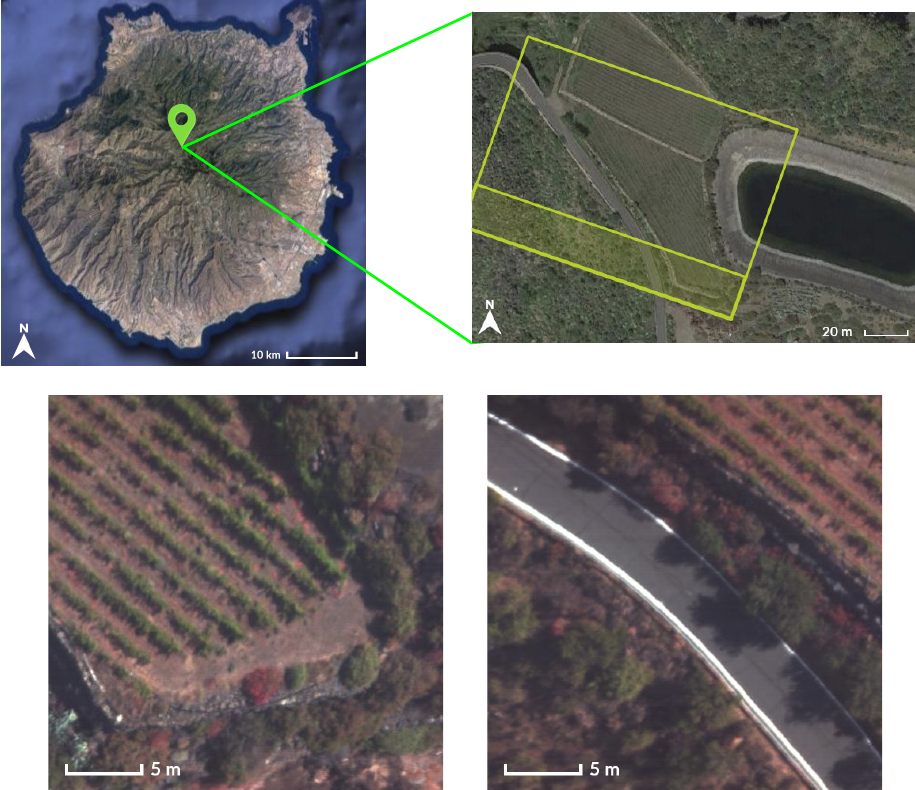
Figure 10. Google Maps pictures of the vineyard areas sensed during the first flight campaign. False RGB representations of the hyperspectral images employed in the